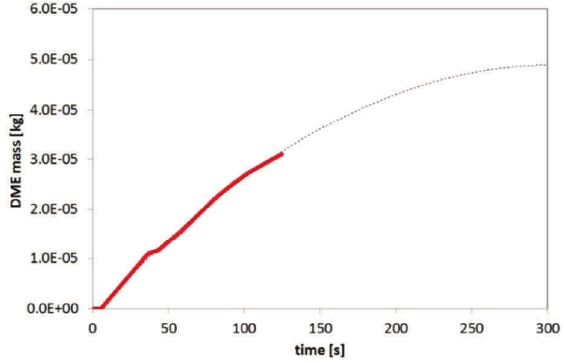
Fig. 9. DME gas accumulation in the engine compartment, leakage variant II Locally, DME concentrations in the air can be significantly higher, but for the first 120 seconds of the test (Fig. 10 and 11), no dangerous levels were reached in any of the controlled sections.